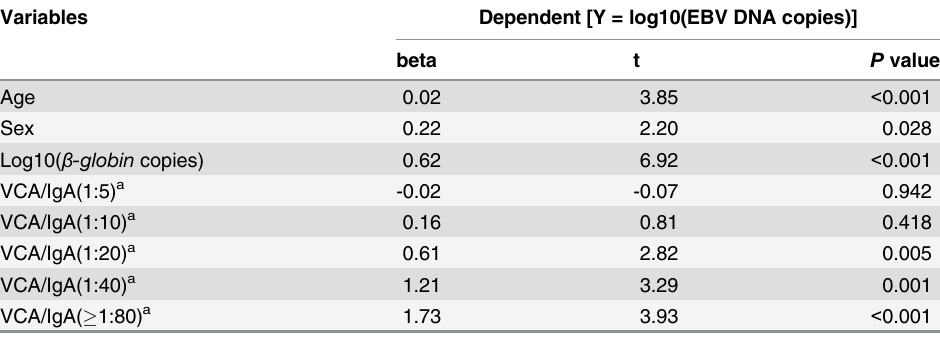
Table 3. Multivariate liner regression for the relation between age, sex, β -globin copy numbers, serum VCA/IgA and nasopharyngeal EBV DNA load.